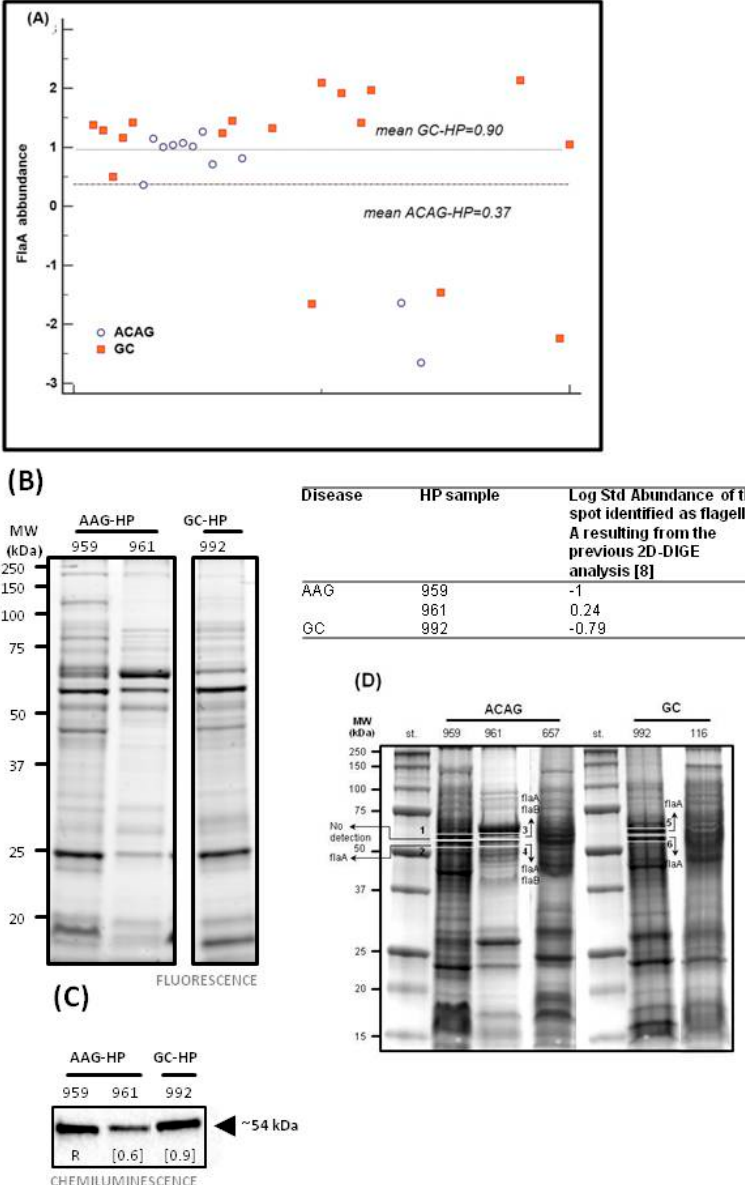
Figure 2. Proteomic characterization of flagellin A. ( A ) Abundance of flagellin A spot in a validation set of H. pylori isolates of 11 AAG patients compared to isolates of 18 GC. The mean value of flagellin A abundance was lower (0.37) in H. pylori isolates from ACAG than those previously obtained in a set of H. pylori isolates from GC patients (0.90) [6]. ( B ) One dimensional electrophoresis (1DE) strain-free gel acquired upon excitation with the Chemidoc system before its transfer to nitrocellulose membrane and ( C ) immunoblotting validation of flagellin expression in H. pylori isolated from either AAG (samples 959 and 961) and one GC (sample 992). Chemiluminescence signals of proteins cross-reacted with the anti-flagellin antibody were detected at around 54 kDa. Numbers refer to the relative quantity of the band calculated with the Image Lab TM software (R, reference band for which quantity is 1). Table report the details of protein abundance (Log Std Abundance) related to a two-dimensional electrophoresis (2D) spot previously identified as flagellin A in the 3 samples analysed [6]. ( D ) One dimensional electrophoresis (1DE) and identification of flagellins A (flaA) and B (flaB) in H. pylori isolated from either ACAG and GC. Two portions in the ~50–60 kDa area of the blue-stained 1DE gel were excised from each sample (AAG-HP: 959 and 961; GC-HP: 992) and submitted to analysis by mass spectrometry for protein identification. Arrows in the gel portions indicate the presence of flaA in all the samples and flaB in the only 961